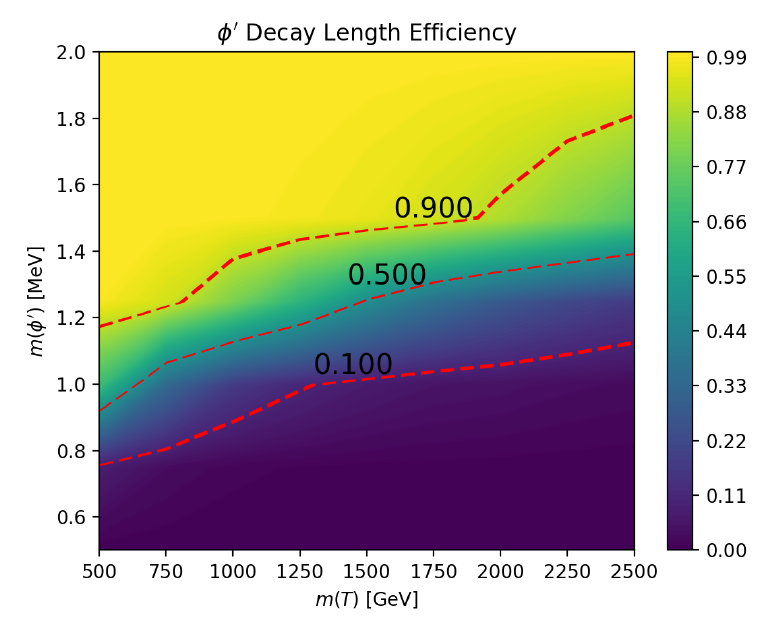
Figure 4 . φ 0 decay length efficiency, showing 90% , 50% , and 10% efficiency levels, assuming Γ T and Γ φ 0 as described in the text. The contours represent the fraction of events decaying inside the ECAL